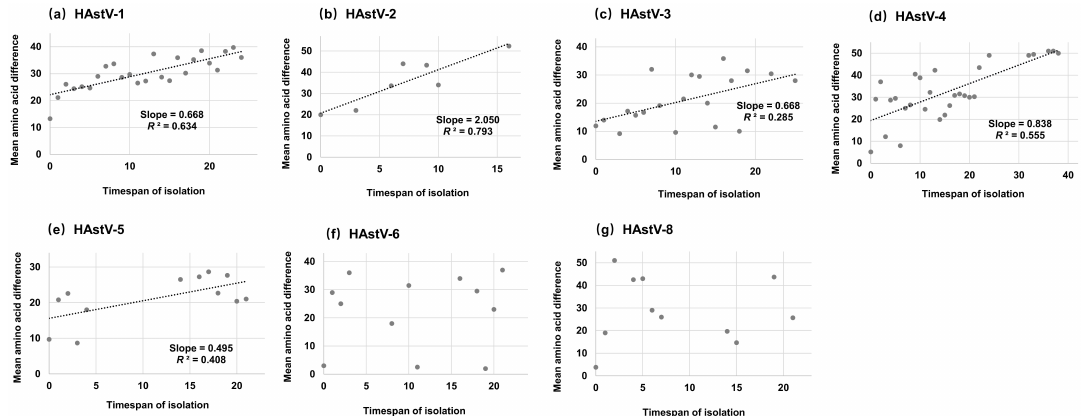
Figure2. AccumulationplotsofaminoacidovertimeofclassicHAstVscapsidproteingene: ( a )HAstV-1, ( b ) HAstV-2, ( c ) HAstV-3, ( d ) HAstV-4, ( e ) HAstV-5, ( f ) HAstV-6, and ( g ) HAstV-8. The X -axis indicates the time-span of isolation, and the Y -axis shows the mean amino acid di ff erence. The dashed line indicates a linear regression line of the mean amino acid di ff erence and time-span of isolation (HAstV-6 and -8 presented no linear signal, and the fitting line was not